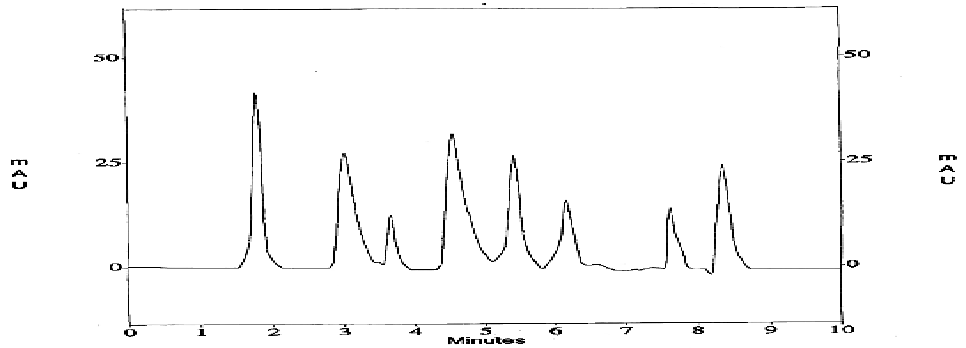
Figure 4. Chromatogram of bioactive phenolic compounds in CHCl 3 /MeOH (2:1 v / v ) SRLe at 245 nm .